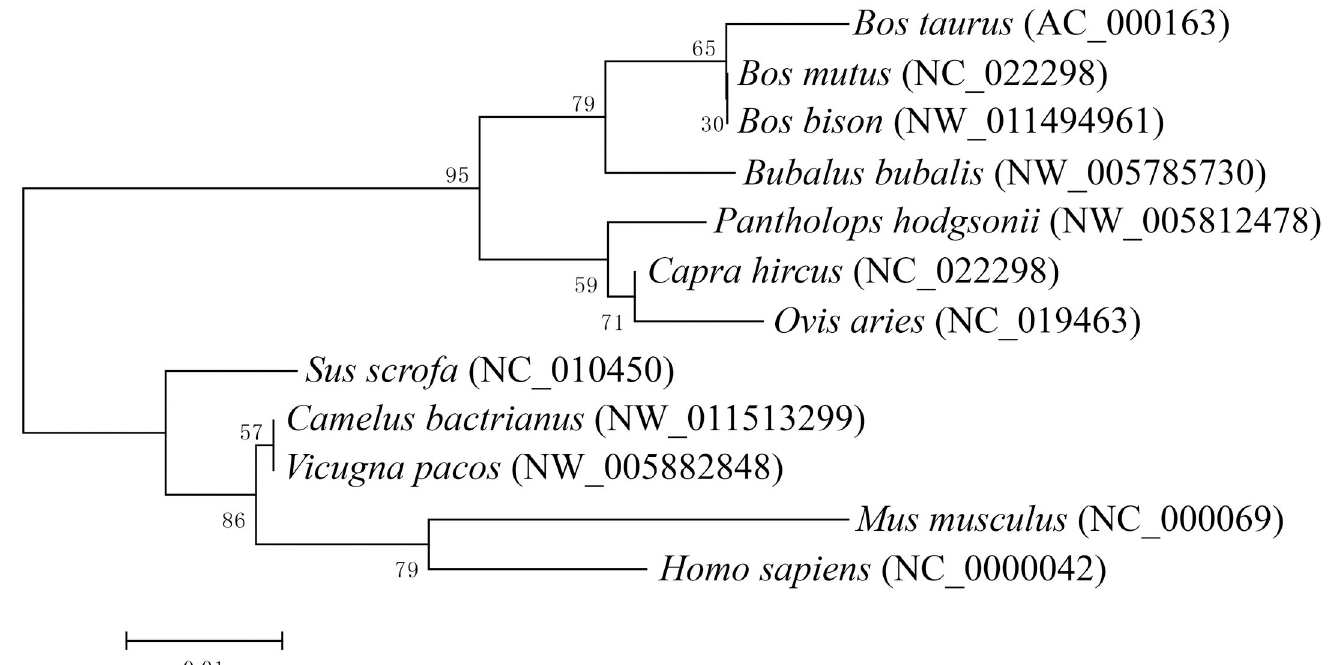
Fig 2. The phylogenetic analysesof bovine ELOVL6 promoter. The phylogenetic relationship was analyzedby NeighborJoiningmethod (Mega programversion 6.0) utilizingbovine ELOVL6 promoter and homologous sequencesfrom other mammal species. Bootstrap values were obtainedfrom 1000 repetitions and illustratedas percentagesat the nodes. The evolutionary distanceof 0.01 nucleicacid substitutions per position was represented at the scale bars.